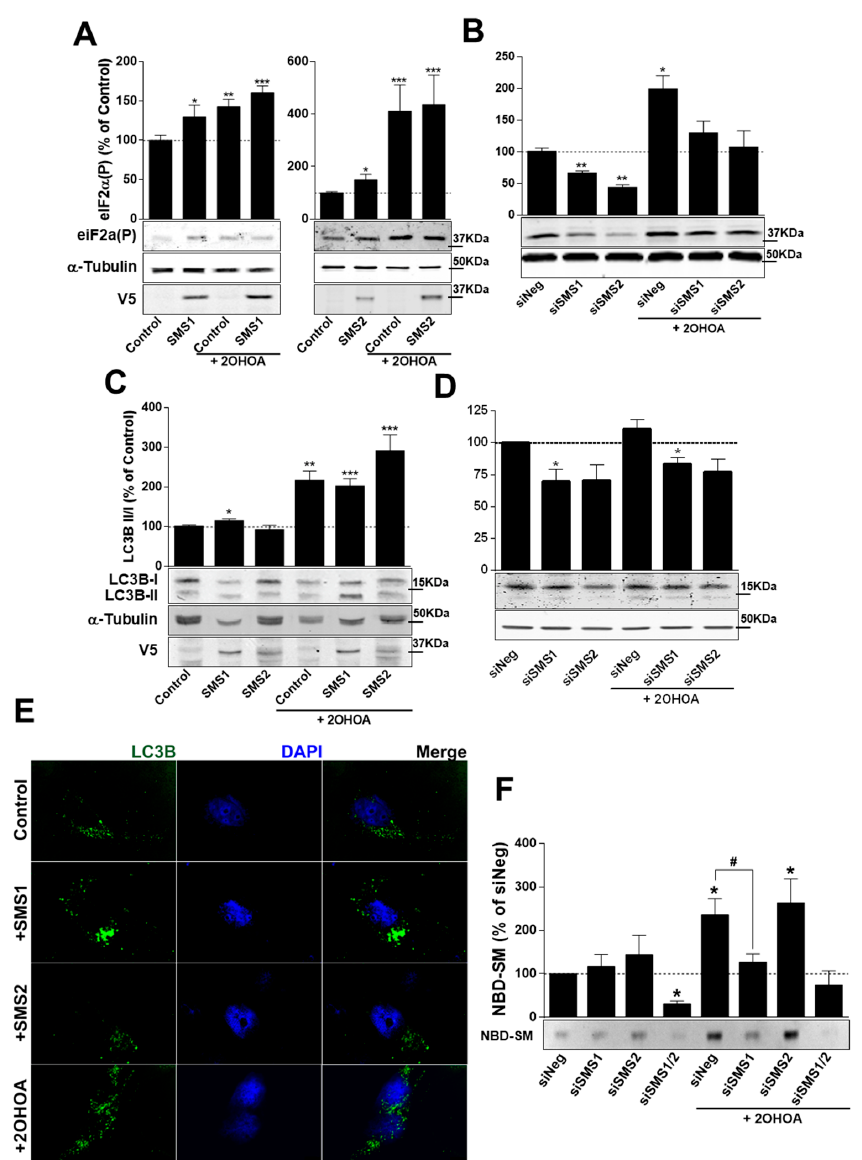
Figure 6. Effects of SMSs and 2OHOA on ER stress and Autophagy in U118 cells. Phospho-eIF2 α [eIF2 α (P): S51] levels in U118 cells, determined by immunoblotting, ( A ) after 72-h treatment with doxycycline (1 µ g/mL) to induce SMS1 or SMS2 overexpression, 2OHOA (200 µ M), or both, or ( B ) after treatment with siRNA targeting SMS1 or SMS2 for 48 h, with 2OHOA (200 µ M) for 24 h, or both. Levels of LC3B II-to-LC3B I determined by immunoblotting in U118 cells ( C ) after 72-h treatment with doxycycline (1 µ g/mL) to induce SMS1 or SMS2 overexpression, 2OHOA (200 µ M), or both, or ( D ) after treatment with siRNA targeting SMS1 or SMS2 for 48 h, with 2OHOA (200 µ M) for 24 h, or both. Untreated cells or cells not overexpressing SMSs were used as controls (100%), and the bars represent mean ± s.e.m values from 4–8 independent experiments; The differences were analyzed using a Student’s t -test or ANOVA *, p < 0.05; **, p < 0.01; ***, p < 0.001; # p < 0.05; between groups. SMS1 and SMS2 overexpression was measured using an anti-V5 antibody. ( E ) LC3B immunofluorescence (green) in U118 cells overexpressing SMS1, SMS2 or after 2OHOA treatment (200 µ M) for 72 h. Nuclei were labeled with DAPI. Representative micrographies (single confocal plane) are shown. Scale bar, 5 µ m. ( F ) NBD-SM synthesis after 3-h incubation with NBD-C6-Ceramide in U118 cells previously treated for 48 h with siRNAs (siNeg, siSMS1, siSMS2 or siSMS1+siSMS2) and in the presence or absence of 200 µ M of 2OHOA (12